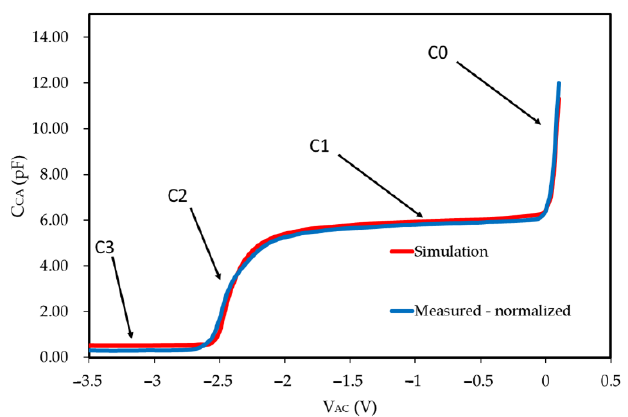
Figure 4. Capacitance-voltage characteristics of measurement and simulations.